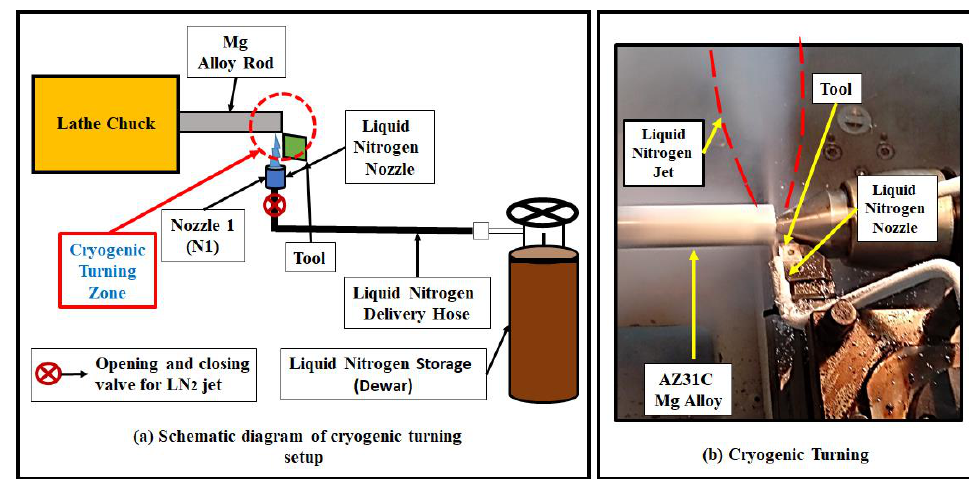
Figure 1. Details of the experimental setup.